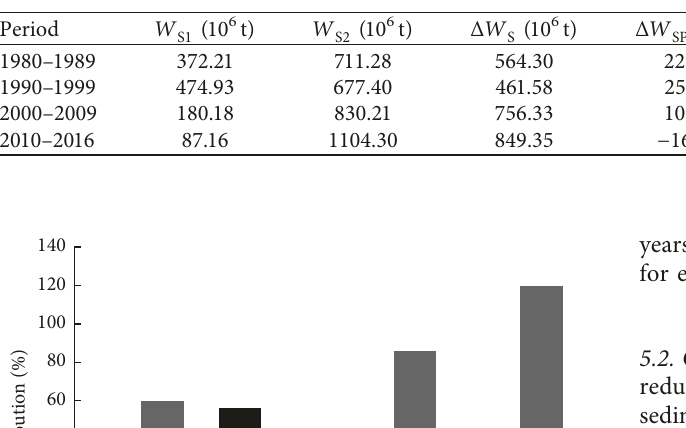
Table 6: Attribution of the change in sediment yield in the HLR since 1980.